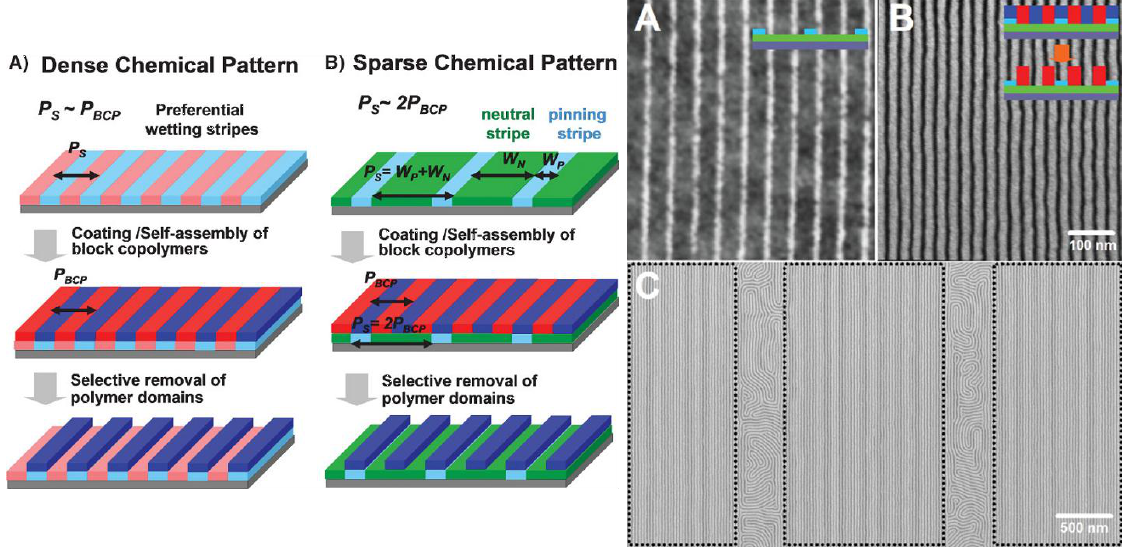
Figure 5. Density multiplication and directed assembly using chemical patterns. E-beam lithography defines sparse pinning stripes. (Left) Comparison of schemes for directing BCP self-assembly. Scheme B) was used to induce density multiplication. (Right) A) shows the sparse e-beam resist lines defining the pinning stripes. B: resulting PS- b -PMMA pattern showing density multiplication. Reprinted with permission from Reference [35].